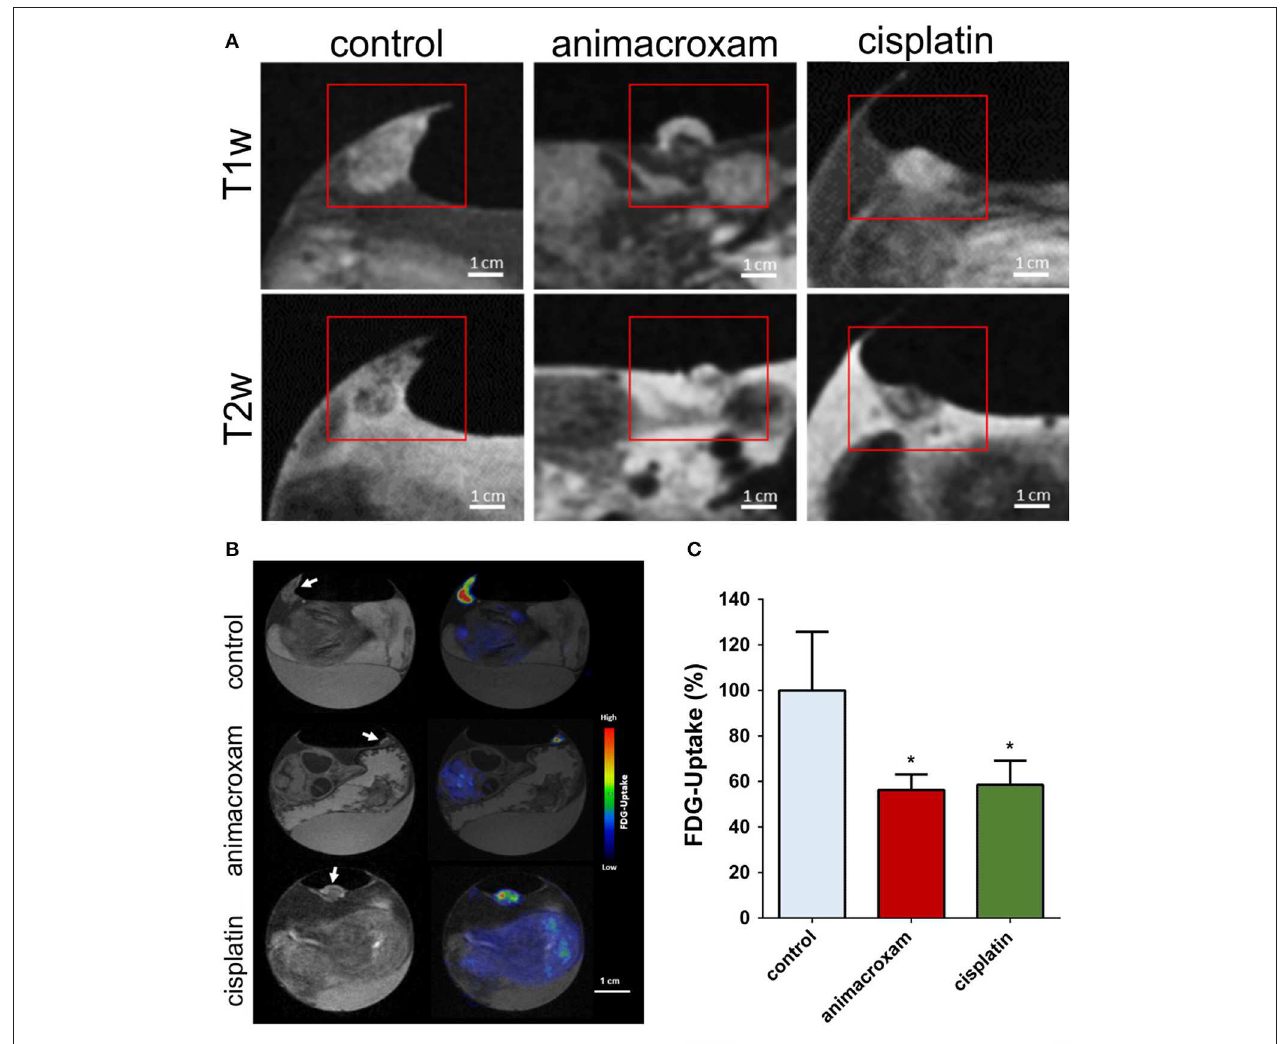
FIGURE 10 | Animacroxam induces ‘cap formation’ and suppresses glucose uptake in inoculated TGCT plaques. (A) T1w and T2w images of control-, animacroxam-, and cisplatin-treated tumor plaques. Animacroxam-treated tumors show a distinct viable tumor core (dark in T1w-/bright in T2w images) and a necrotic cap (bright in T1w-/dark in T2w images). (B) T1w and corresponding PET-MR images of [ 18 F]-FDG uptake in tumor plaques treated with NaCl, animacroxam, or cisplatin. (C) Animacroxam (5.0 µ m)- and cisplatin (2.5 µ m)-treated tumor plaques showed a reduced uptake of [ 18 F]-FDG. Results are shown as means ± SEM of at least n = 3 independent experiments. Scale bar = 1 cm. * P -values of ≤ 0.05, unpaired t -test. This research was originally published under the terms of the Creative Commons Attribution License (CC BY) in Molecular Oncology: Antitumor and antiangiogenic activity of the novel chimeric inhibitor animacroxam in testicular germ cell cancer, Steinemann et al.